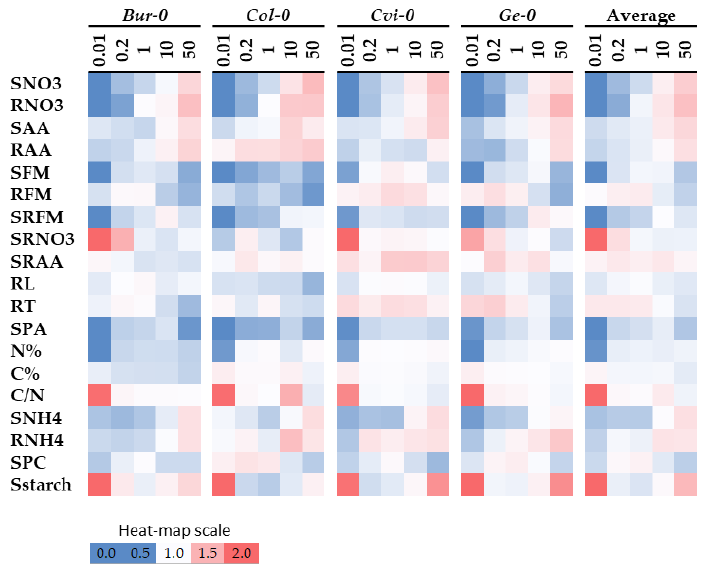
Figure 5. Heat-map of accession changes according to N fluctuations. Values measured in the different N condition are expressed as a ratio to control values (4 mM NO 3 ) for the four accessions ( Bur-0 , Col-0 , Cvi-0 and Ge-0 ) and for the total average (Average). Decreased and increased values in comparison to control are shown in blue and red shades, respectively.